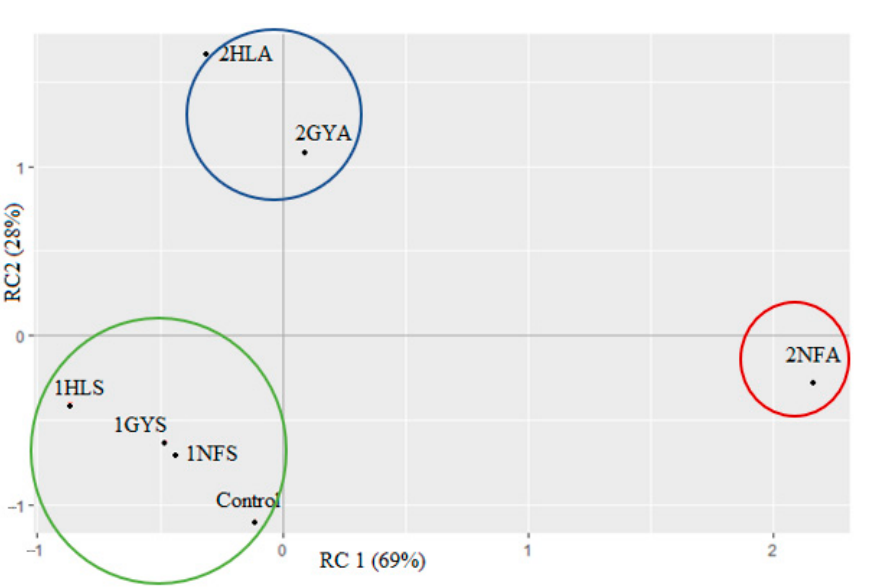
Figure 3. Principal component analysis (PCA) generated from the sensory properties of hydrolysed whey permeates after first-stage fermentation. Using sweet whey permeate and enzyme 1GYS— GODO-YNL2; 1NFS—NOLA™ Fit5500; 1HLS—Ha-Lactase 5200. Using acid whey permeate and enzyme 2GYA—GODO-YNL2; 2NFA—NOLA™ Fit5500; 2HLA—Ha-Lactase 5200. Control—commercial glucose-galactose syrup. The values with the same letter within each column do not differ significantly ( p > 0.05).